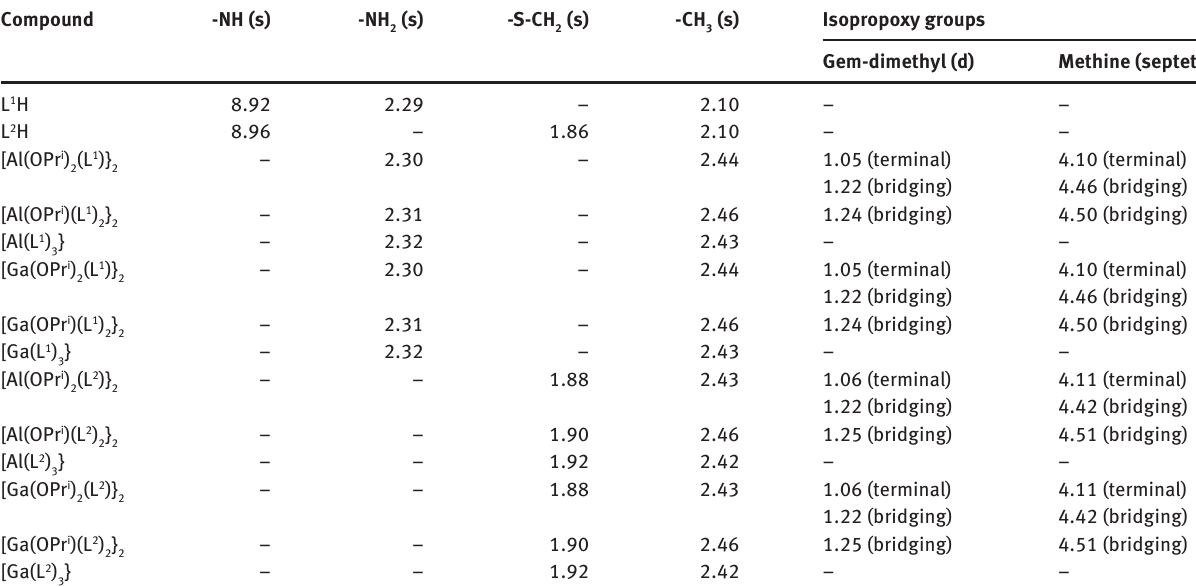
Table 2 1 H NMR spectral data ( δ , ppm) of the ligands and corresponding metal complexes. Compound